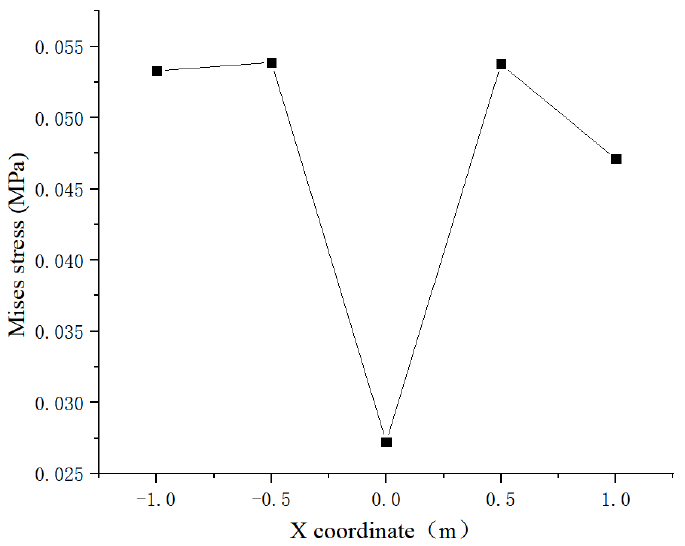
Figure 26. Variation of wall Mises stress at 14.625 m under different load positions.